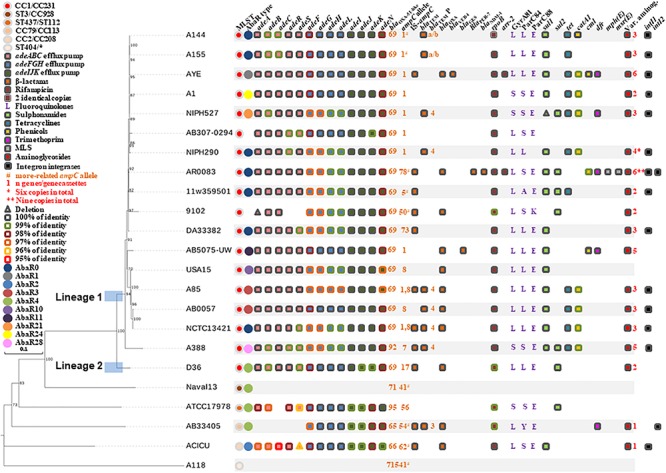
Molecular phylogenetic analysis and antimicrobial resistance determinants of GC1 Group 1 and Outgroup Group 3. The evolutionary history was inferred by using the Maximum Likelihood method based on the General Time Reversible model. The inset legend indicates the genetic determinants highlighted. When required, blastn was used with a cut-off E-value of E–10.